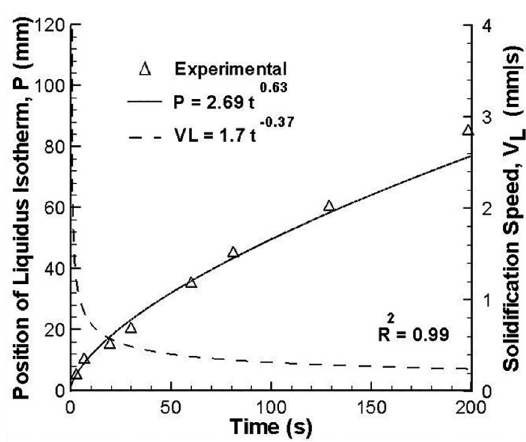
Figure 4. Position of liquidus temperature ( P ) and solidification speed ( V ) versus L